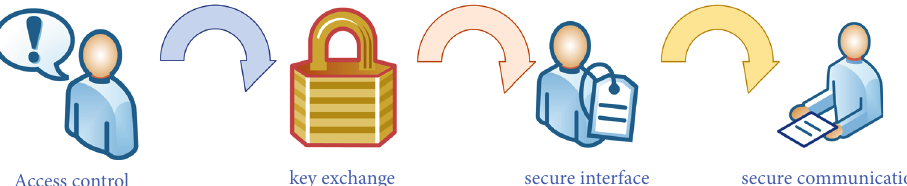
Figure 3: Security policy